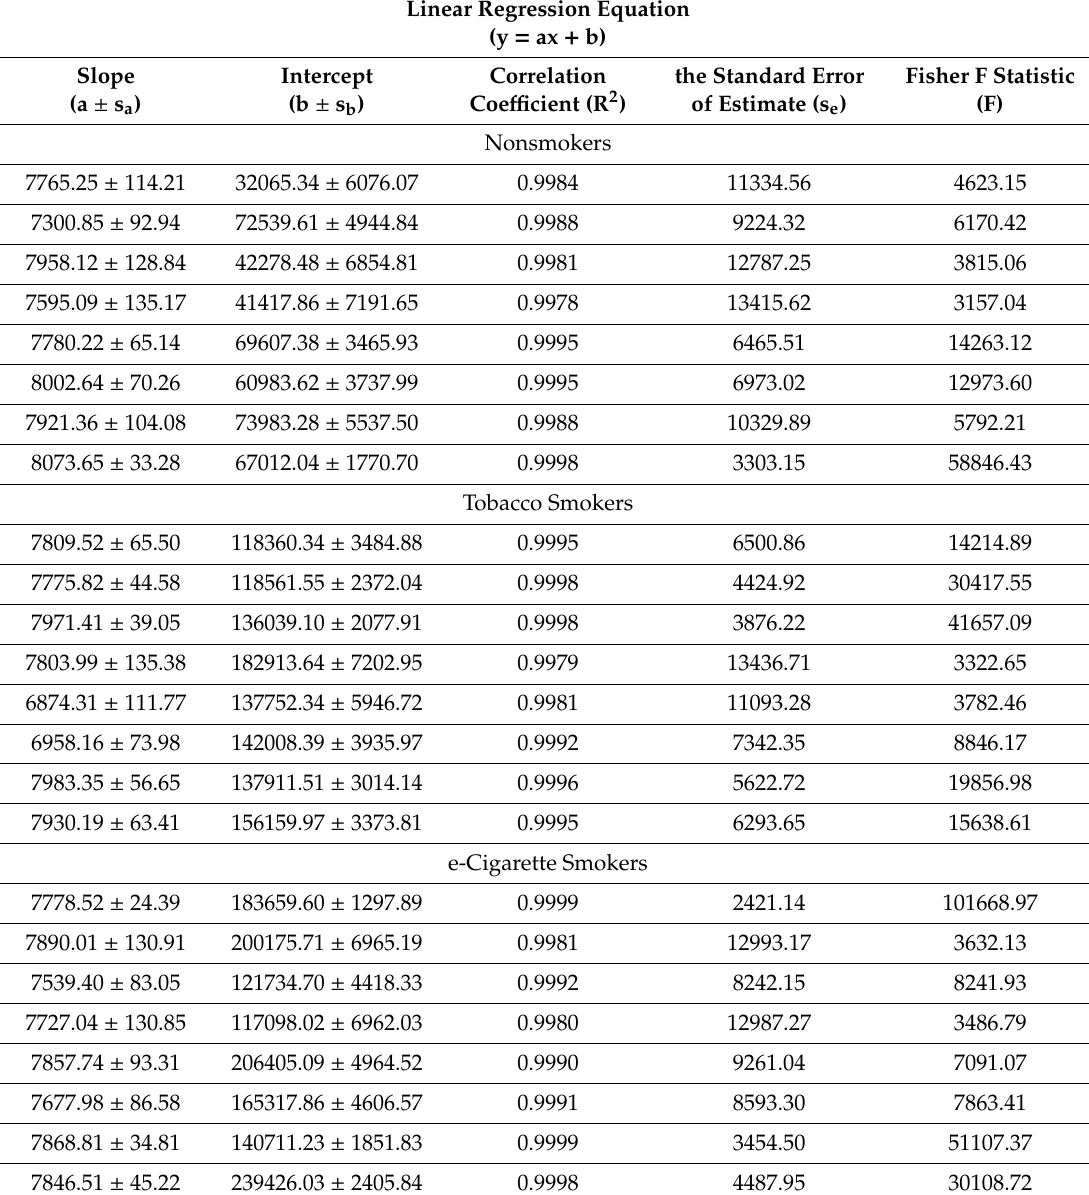
Table 3. Calibration data ( n =